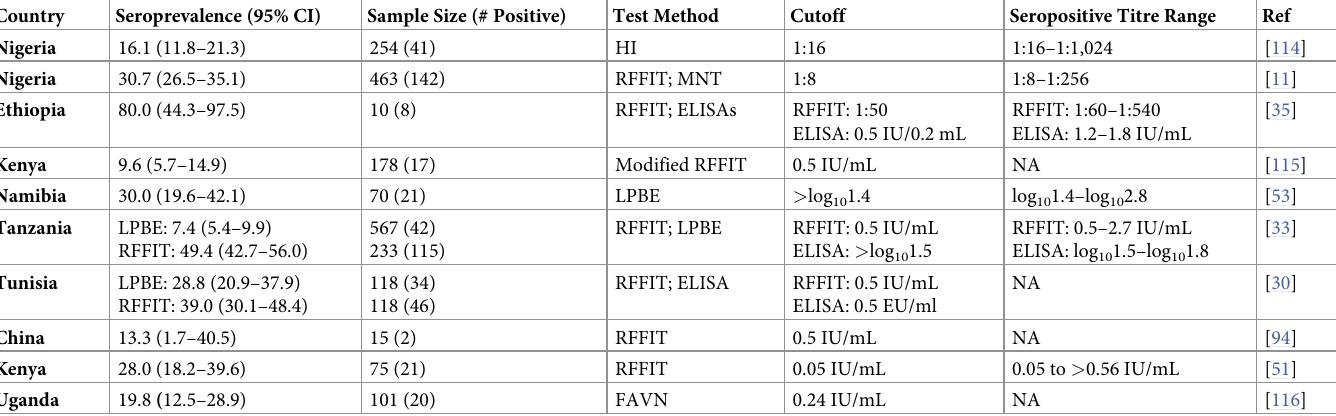
Table 1. Serology surveys in unvaccinated domestic dogs yielding the estimated percentage with detectable rabies-specific antibodies in serum. Country